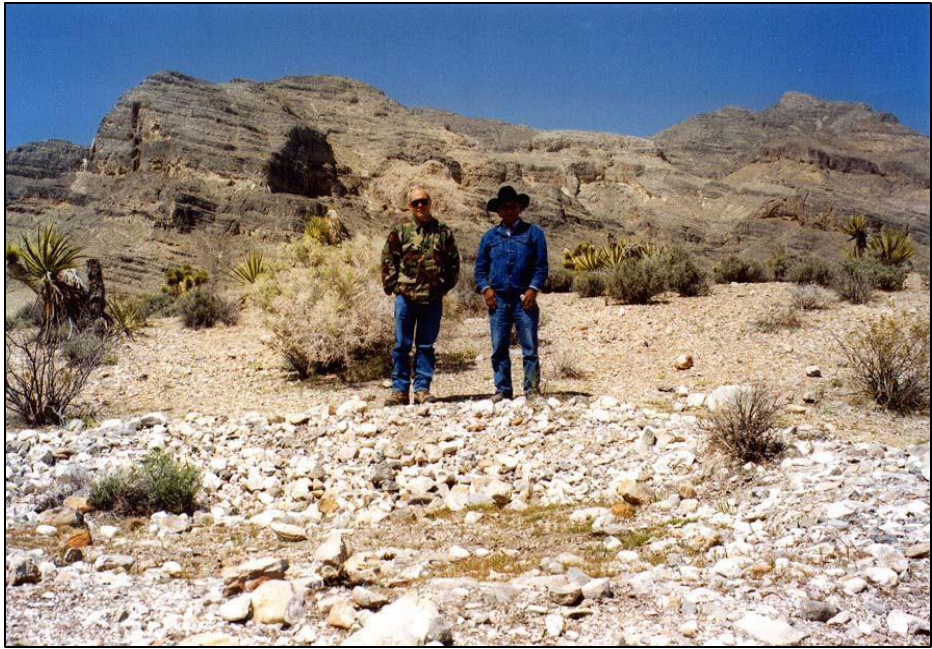
Figure 20. Representatives and a large roasting pit (Source: